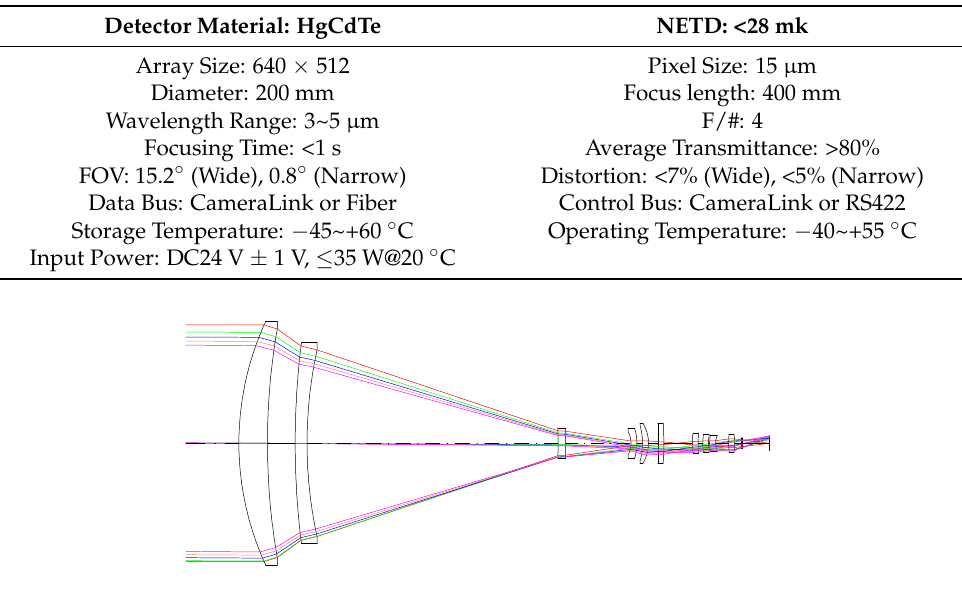
Figure 6. Schematic of the medium-wave infrared imaging sensor.